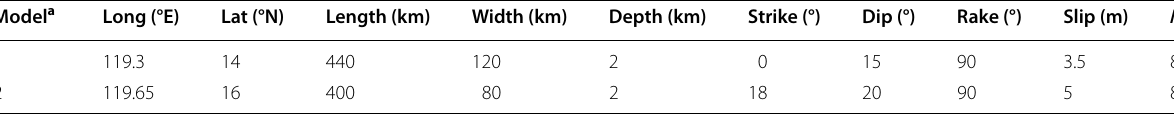
a 1-megathrust fault; 2-upper-plate fault